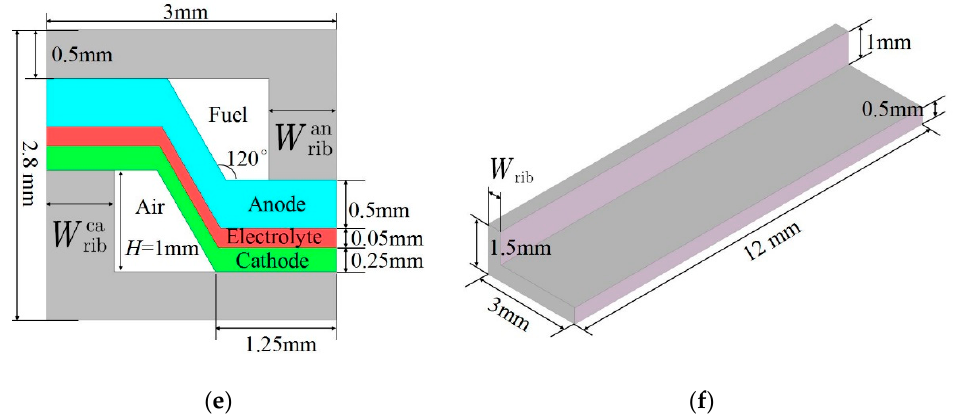
Figure 1 . ( a ) Conventional design; ( b ) vertical rib design; ( c ) conventional design model simulation domain; ( d ) vertical rib design model simulation domain; ( e ) the size of vertical rib design; ( f ) vertical rib size.